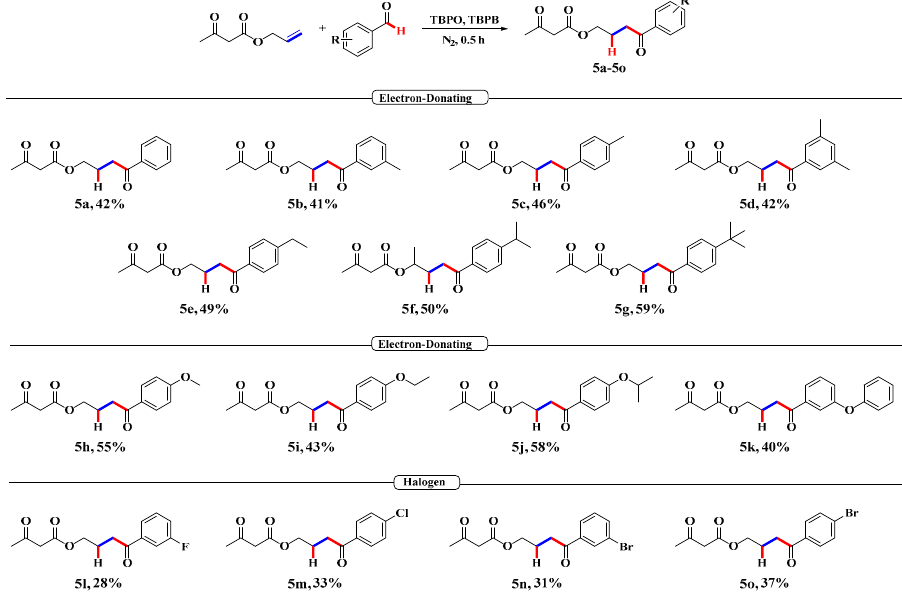
Figure 3. The radical additions of allyl acetoacetate with substituted